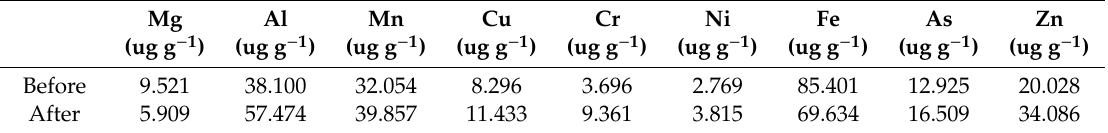
Table 4. SCS I composition before and after experiment.